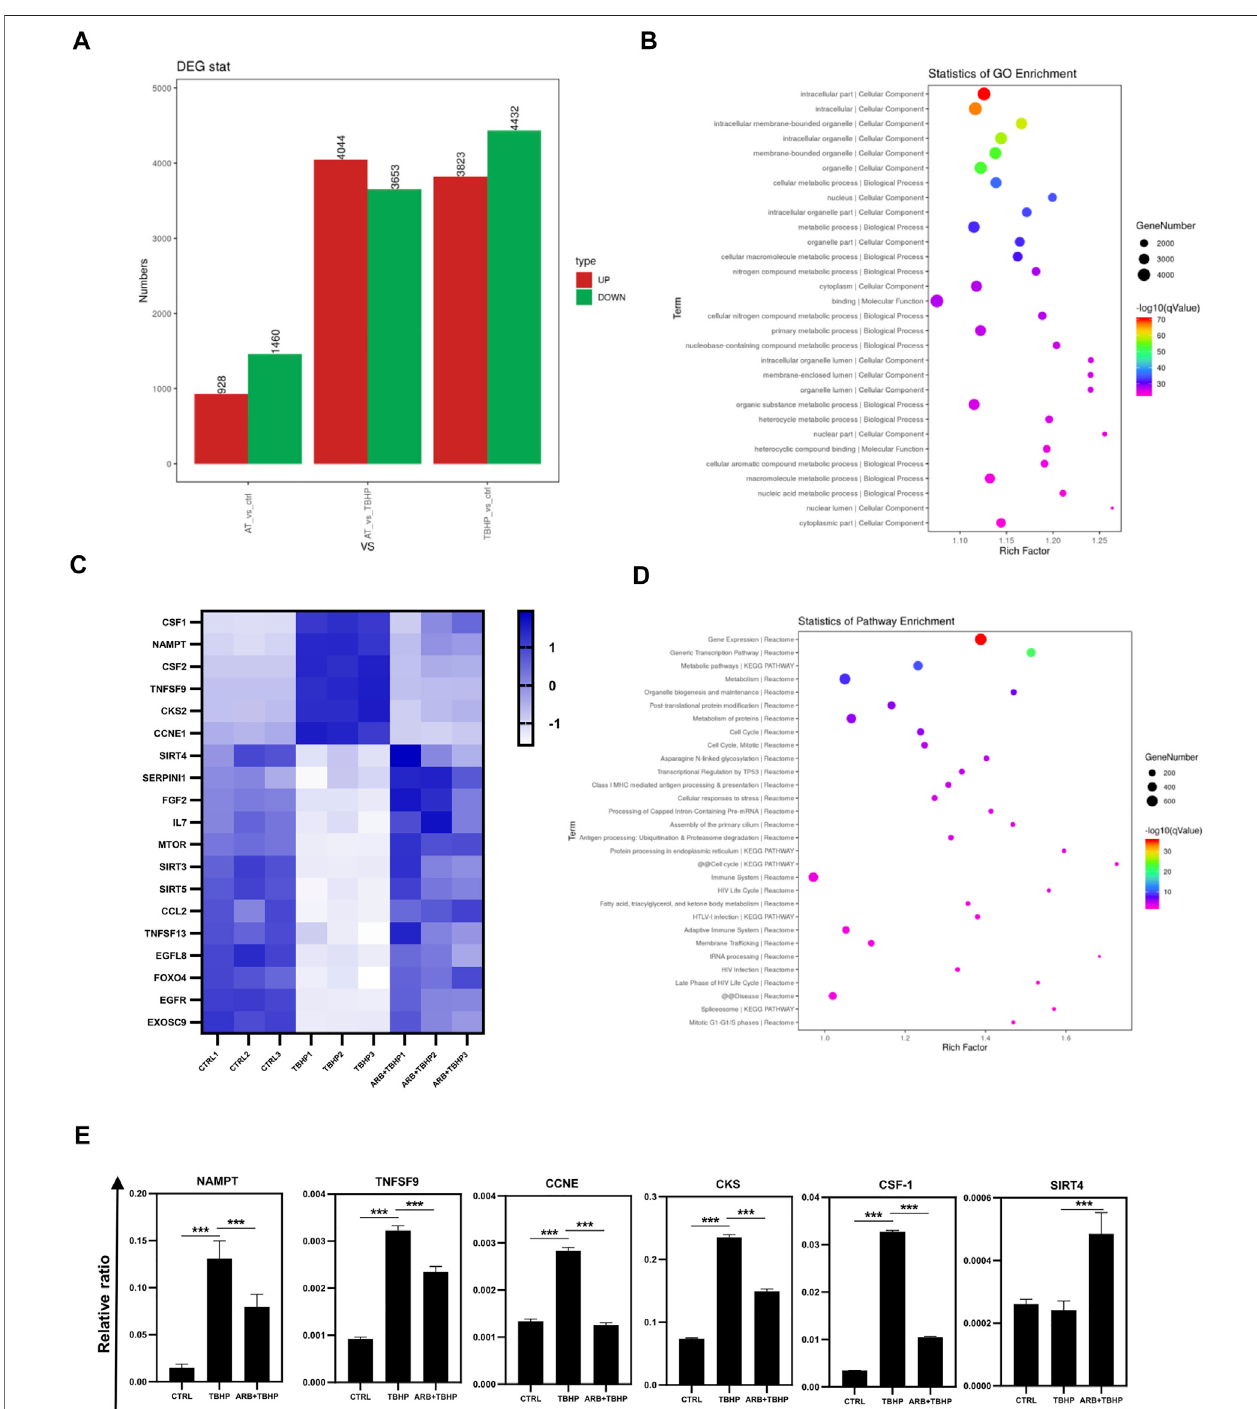
FIGURE 2 | Transcriptome sequencing (RNA-seq) of ARPE-19 cells protective by Arbutin. (A) the number of differentially expressed genes among the control, TBHP injury, and Arbutin pretreatment groups (AT refers to Arbutin and TBHP). (B) GO pathway enrichment results of differential genes. (C) heatmap of differential expressionofgenesrelatedtocellagingandmitochondrialhealthindifferentexperimentalgroups. (D) pathwayenrichmentresultsofpartiallydifferentialgenescoincided withheatmap. (E) RT-PCRresultsofgenesrelated tocellagingandmitochondrialhealthindifferentexperimental groups(* p < 0.05,** p < 0.01,*** p < 0.001, n =3, bars represent